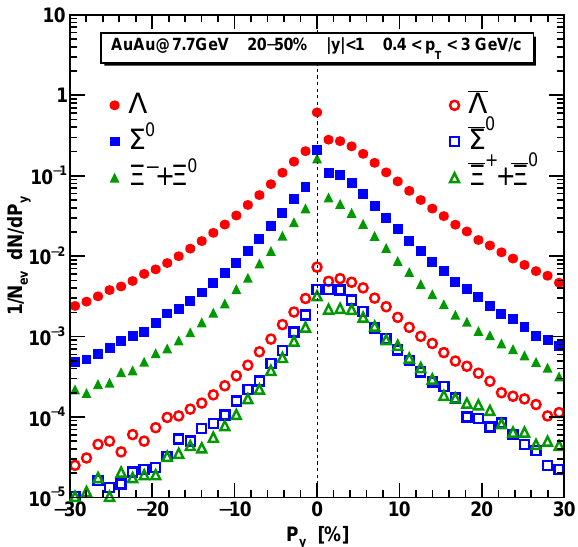
Figure 5. The polarization distributions of the final hyperons and anti-hyperons (without weak and electromagnetic decays) in the semi-central 20–50% Au+Au collisions at the mid-rapidity | y | < 1 and transverse momenta 0.4GeV/ c < p T < 3GeV/ c , normalized on the number of collision events. Table 1. Global polarization of the Λ and ¯ Λ hyperons in Au+Au collisions at √ s NN = 11.5GeV, 20–50% centrality, mid-rapidity | y | < 1 and transverse momentum range and 0.4GeV/ c < p T < 3GeV/ c . The STAR data [1] is scaled to the currently accepted value of the decay parameter α Λ = 0.732 [45]. Λ (prim.) Λ ¯ Λ (prim.) ¯ Λ PHSD 2.14 1.45 3.63 2.31 √ s NN = 7.7GeV STAR 1.79 ± 0.58 7.60 ± 3.25 PHSD 1.63 1.12 2.64 1.77 √ s NN = 11.5GeV STAR 1.18 ± 0.39 1.58 ±